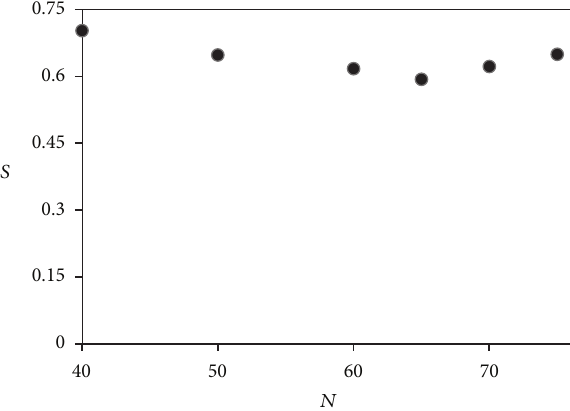
Figure 9: The variation of 𝑆 on changing 𝑁 . For a weak enough coupling LRO is established. 𝑊 = 1 , 𝑃 = 0.1 , 𝑇 = 0.1